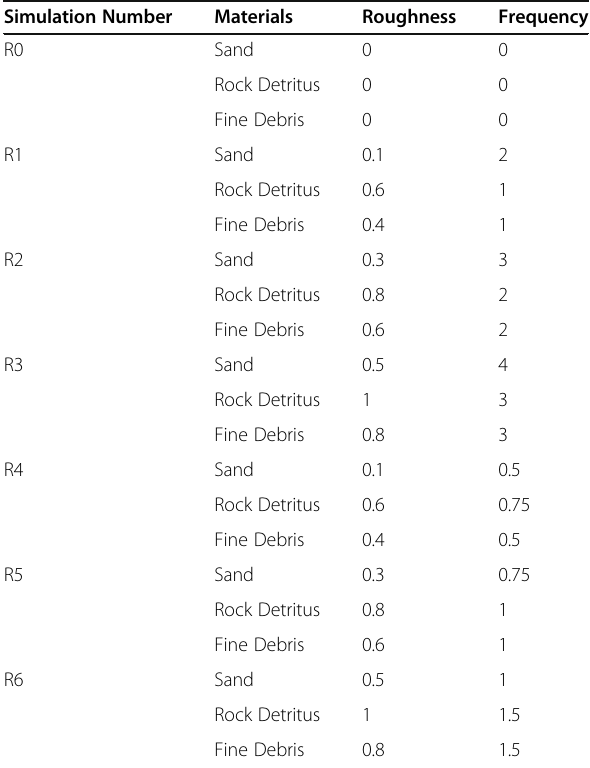
Table 1 Different values of surface roughness and frequency